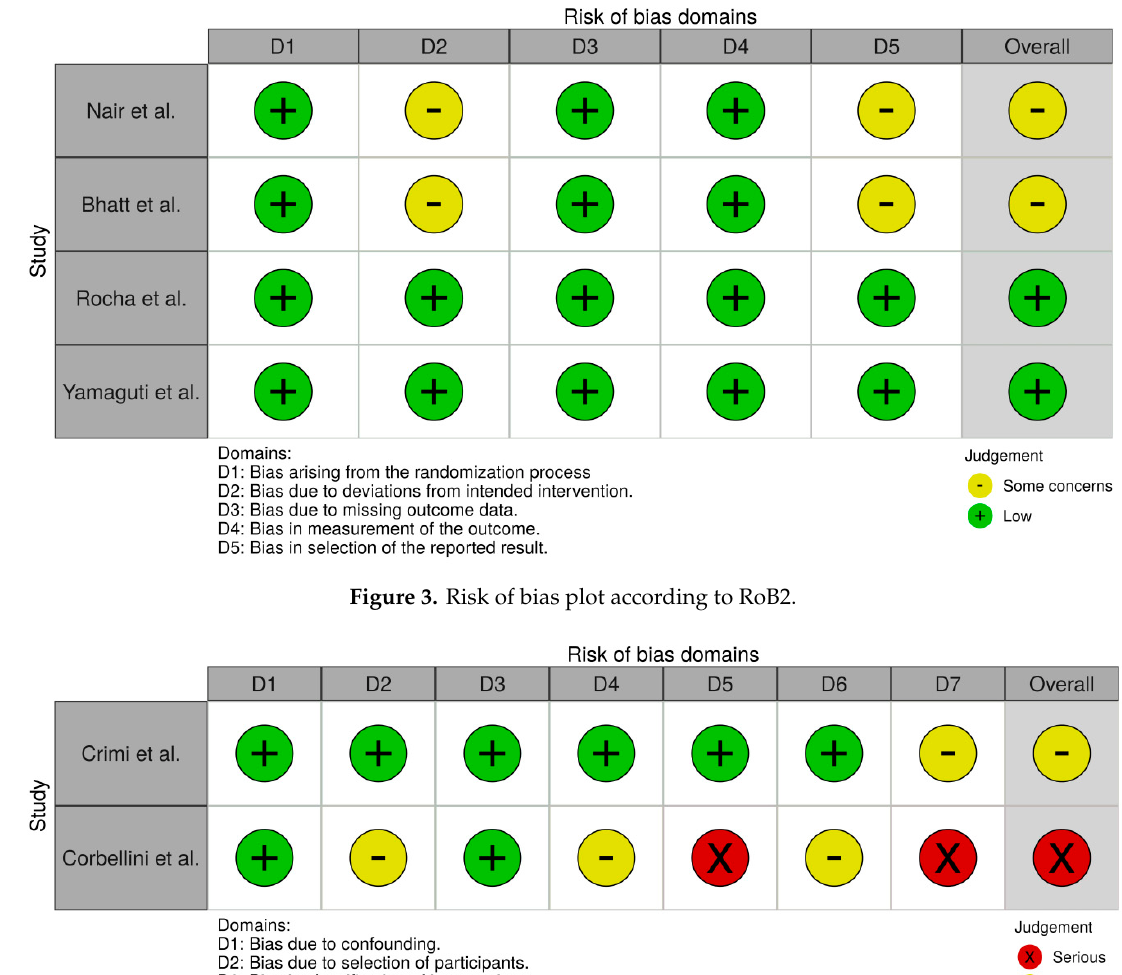
Figure 4. Risk of bias plot according to